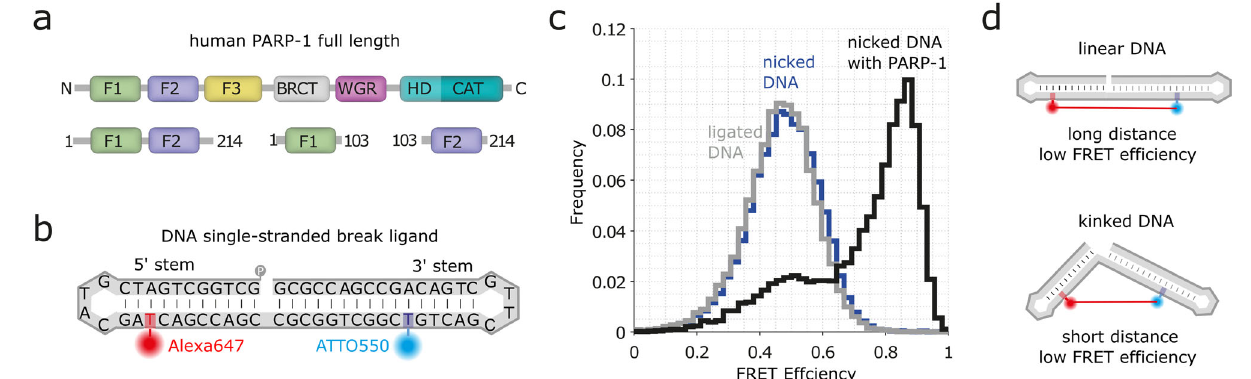
Fig.1|smFRETassayforprobingtheDNAconformationinpresenceofPARP-1. a Domain architecture of full-length PARP-1 and PARP-1 fragments F2 and F1F2. Domains are abbreviated as: F1, F2, F3: zinc fi nger domains; BRCT: breast cancer susceptibility protein C-terminal domain; WGR: WGR domain; HD: α -helical sub- domain; ART: ADP-ribosyl transferase subdomain. b Schematic displaying the sequence and predicted secondary structure of the DNA ligand used in this study.